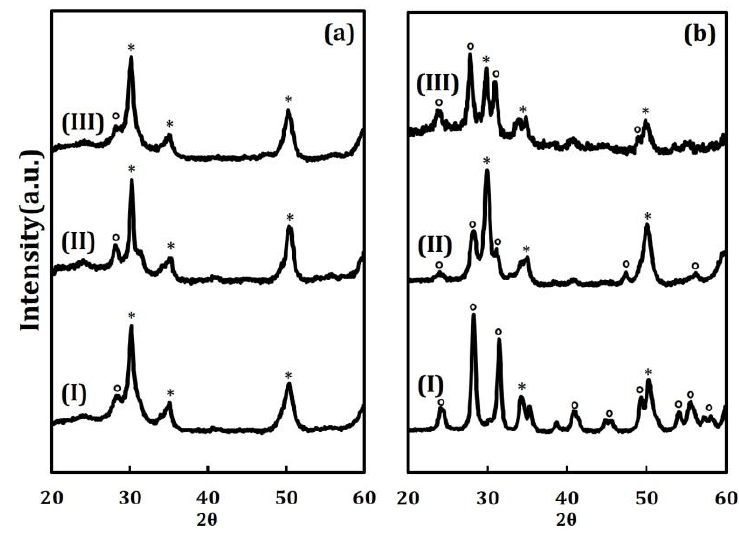
Figure 2. XRD patterns for ( I ) unmodified ZrO 2 , ( II ) 20 CeO 2 /ZrO 2 , and ( III ) 20 ZrO 2 /ZrO 2 . Patterns shown in ( a ) were from samples calcined at 773 K and patterns in ( b ) at 1073 K. Peaks marked with asterisks stand for tetragonal phase ZrO 2 and open circles stand for monoclinic phase ZrO 2 .